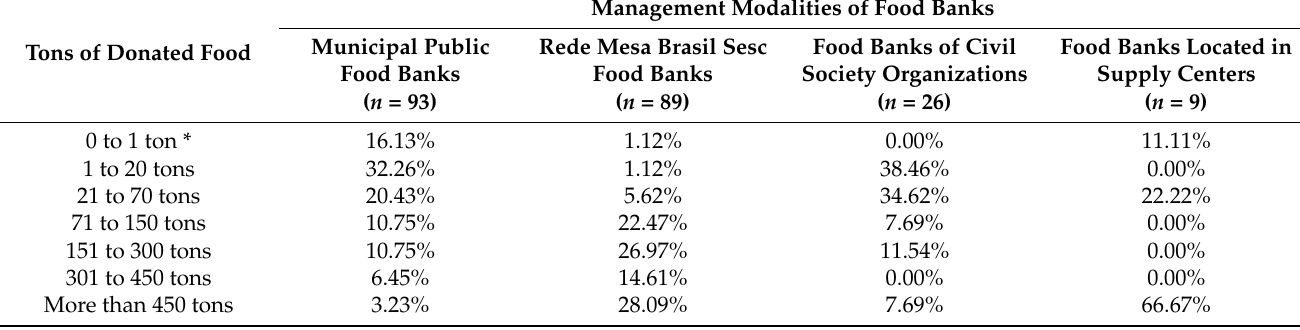
Table 4. Volume of food donated by Brazilian food banks to beneficiary institutions and families by management modalities in 2018 ( n = 217).